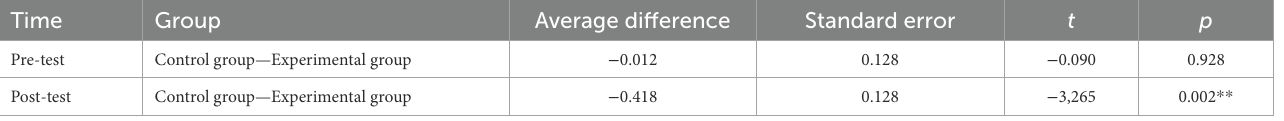
TABLE 5 Simple effects analysis of cooperation ability group between experimental group and control group before and after intervention. Time Group Pre-test